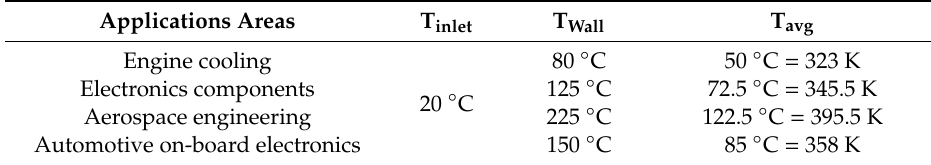
Table 4. Temperature values set in different areas at the outlet in the simulation model.